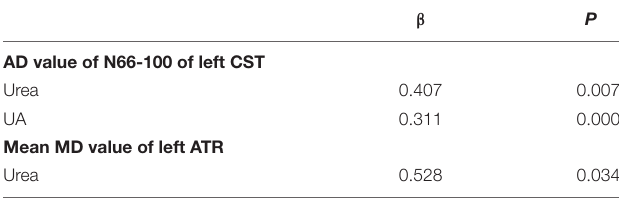
TABLE 2 | Multiple linear regression